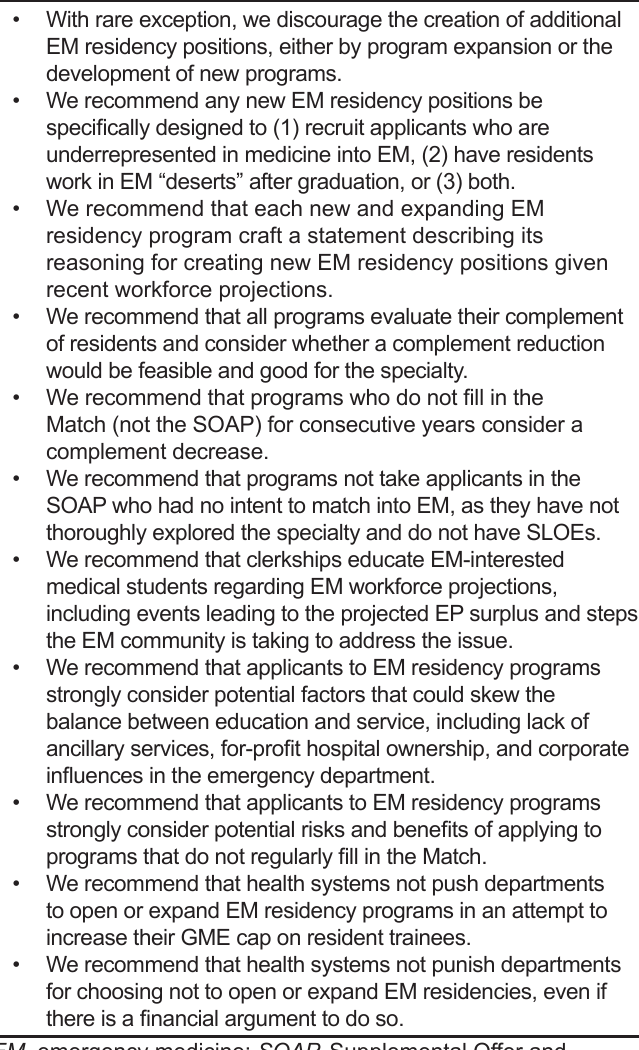
Table 2. Potential guidelines from national EM organizations addressing the supply side of the EM